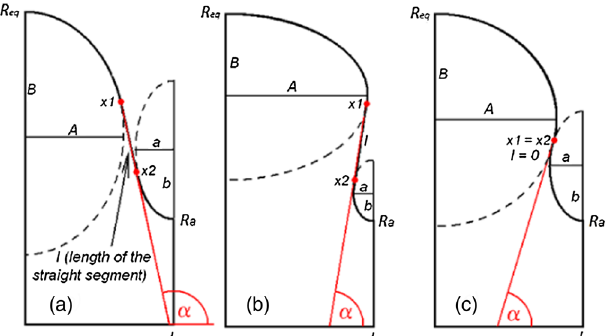
FIG. 2. Geometry of the elliptic half-cell: non-reentrant — (a), and reentrant — (b) and (c). Angle α ¼ 90 ° þ γ , compare to Fig. 1.